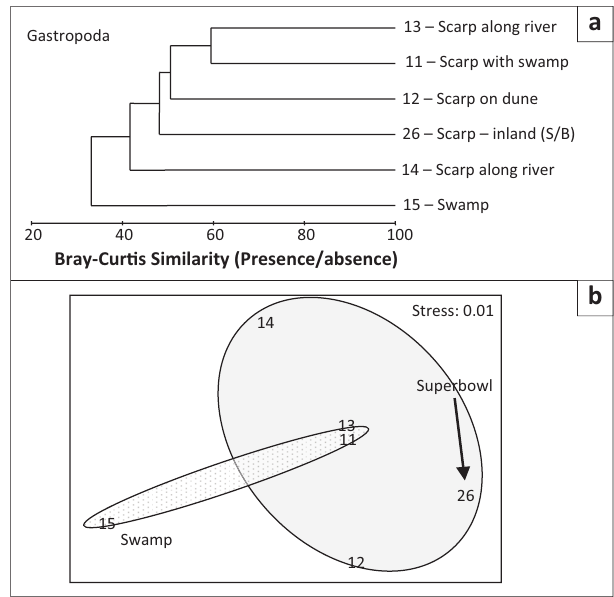
FIGURE 7: Community relationships among forest sites at Mkambati for Mollusca, Gastropoda. (a) Similarity analysis and (b) multi-dimensional scaling analysis.